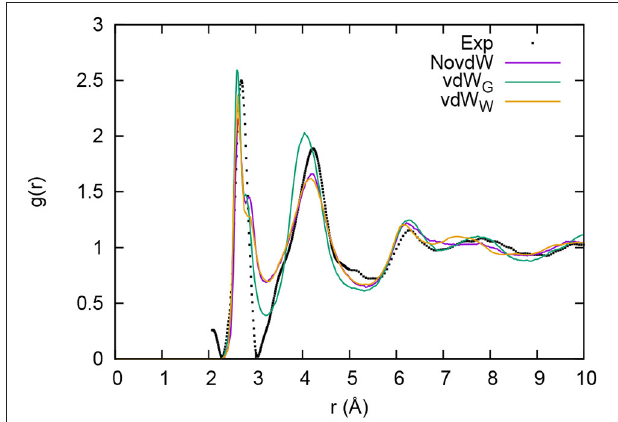
FIGURE 1 | Total correlation function of g -GeTe 4 . Results with no inclusion of vdW interactions (purple line) and with inclusion of vdW interactions following the Grimme scheme (vdW G , green line) (as reported by Bouzid et al., 2015b) are compared to those including van der Waals interaction in the vdW W formalism (orange line). Experiments are from Kaban et al.